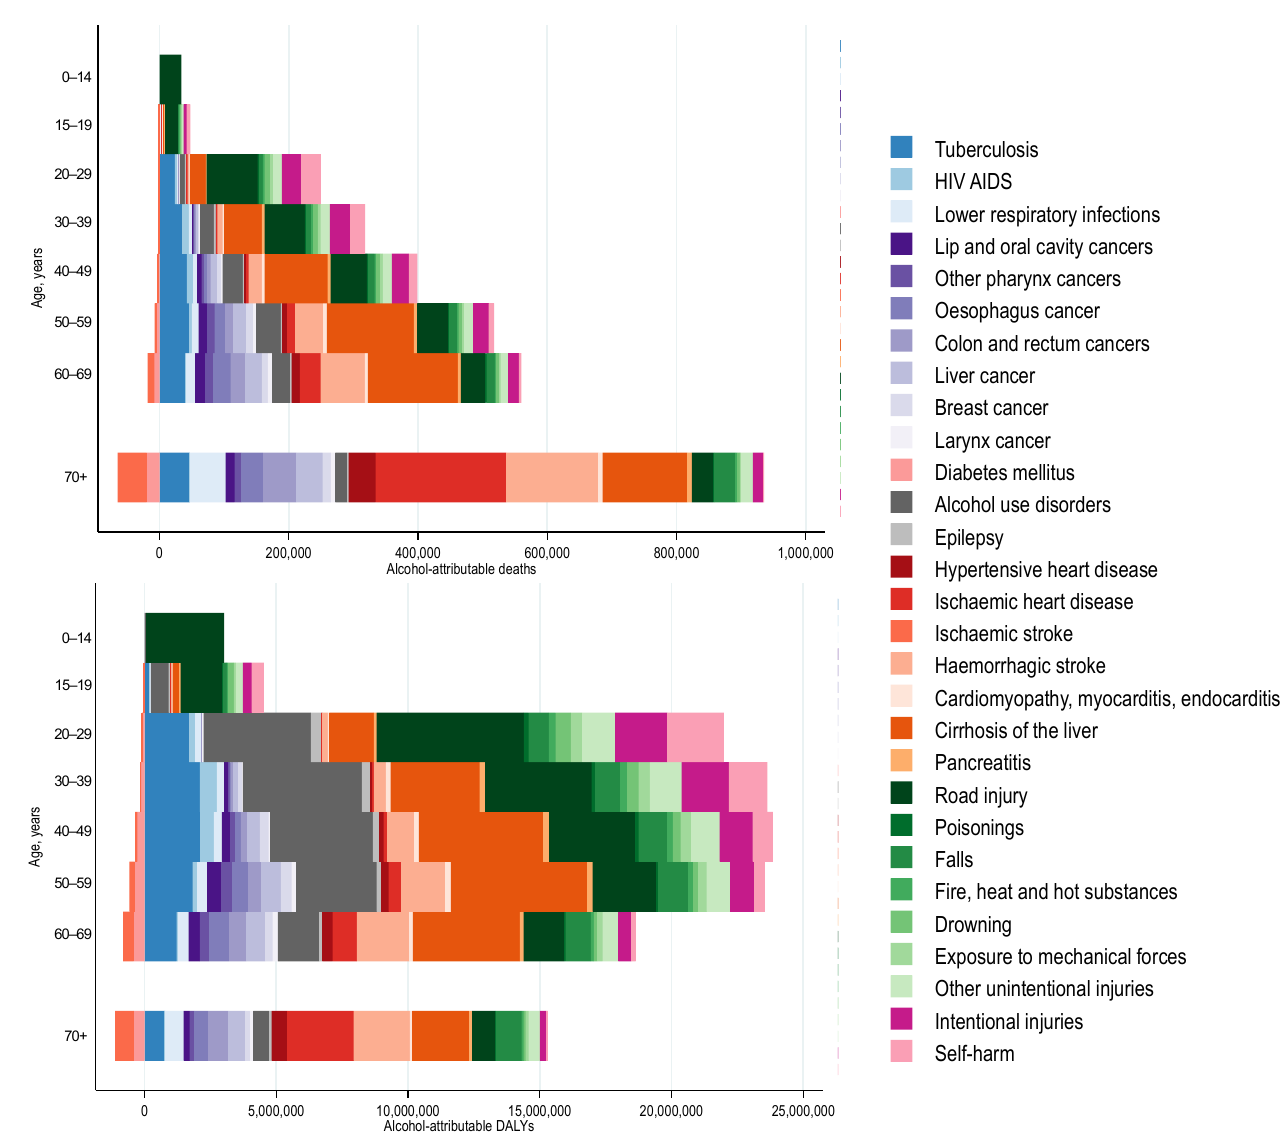
globally. Figure S3 outlines the burden of alcohol-attributable premature YLL and YLD by GBD